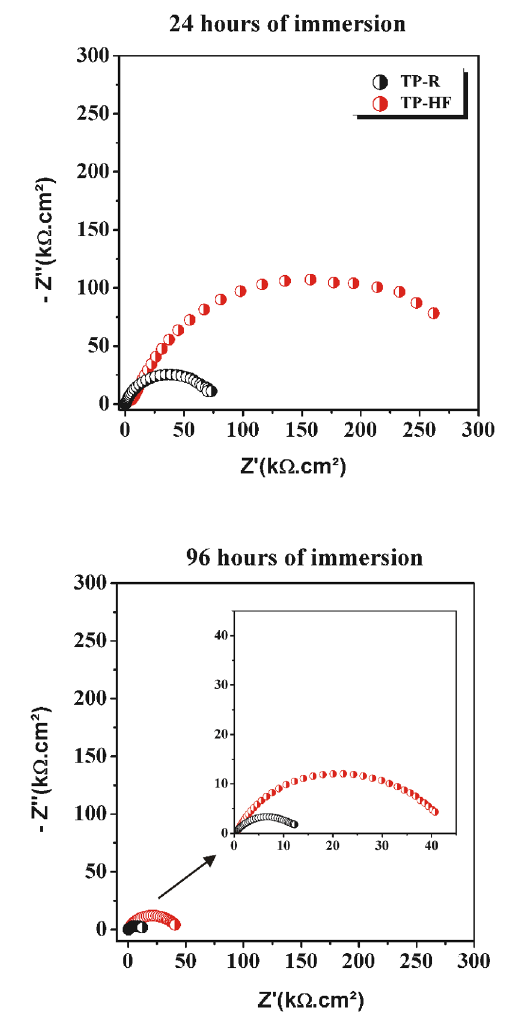
Figure 7. Nyquist diagrams for tinplate uncoated and tinplate coated with the hybrid films for 24 and 96 hours of immersion in 0.05 M